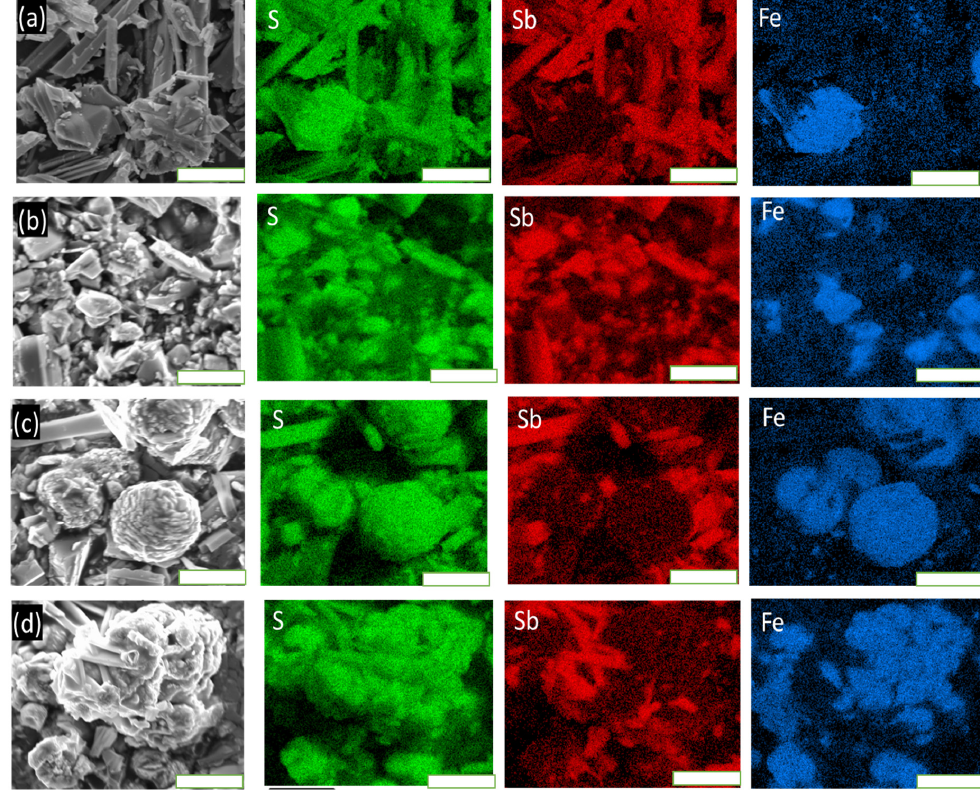
Figure 5. EDX elemental mapping of S k α , Sb L α , and Fe K α for Sb 2(1 − x ) Fe 2 x S 3 prepared by the melt method for 1 h at 450 °C using different mole fractions of iron ( a ) x = 0.2 ( b ) x = 0.4 ( c ) x = 0.6, and ( d ) x = 0.8.